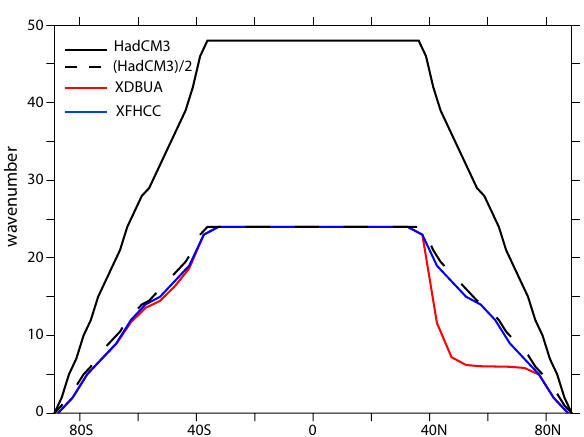
Fig. 4. Maximum wavenumber allowed by the Fourier filtering in DJF. Black, solid: HadCM3; black, dashed: HadCM3 data divided by 2, a profile that might be expected of a model with half the reso- lution of HadCM3; green: XDBUA; blue: